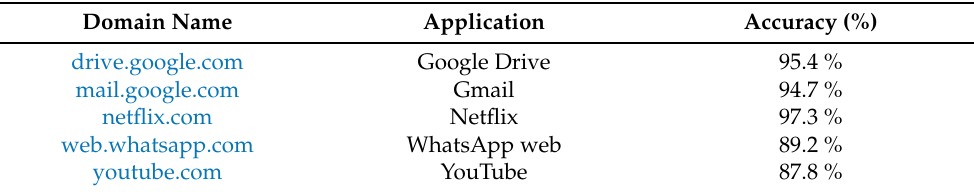
Table 1. Per-application accuracy achieved by the proposed classification system (processing only packets transmitted in the first 40 ms of web and encrypted flows). Summary of experimental results